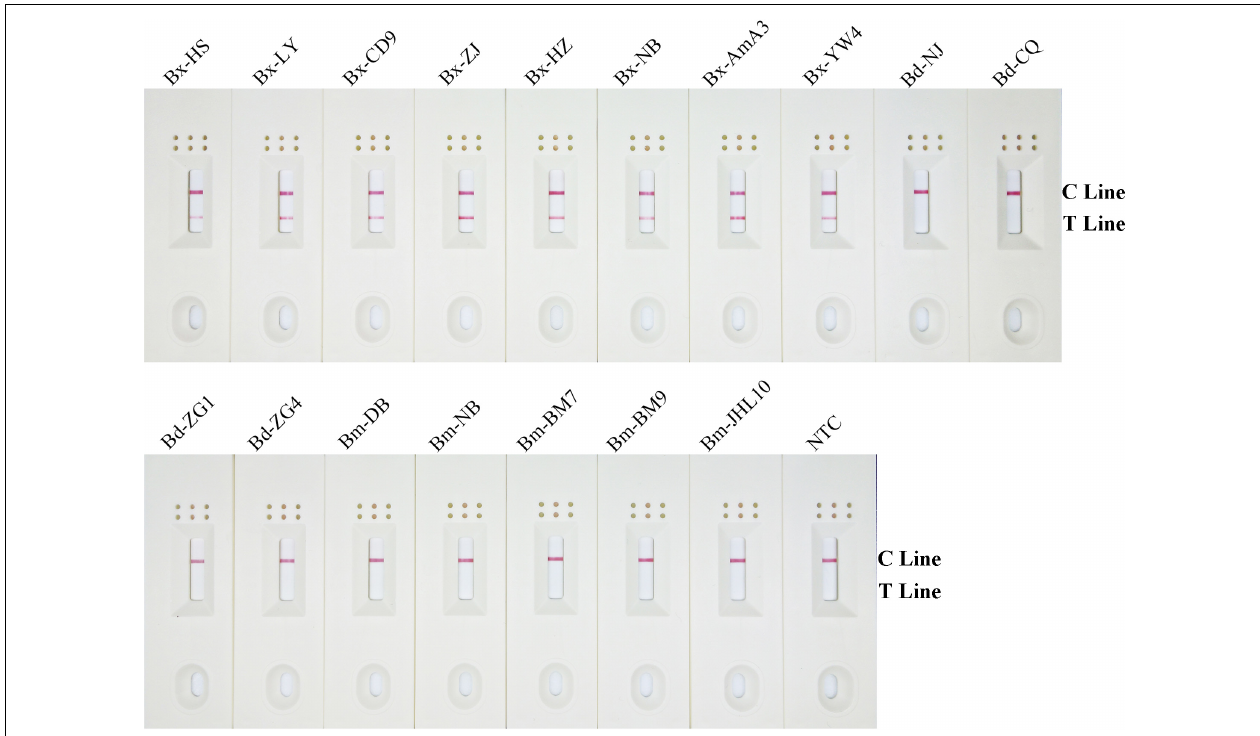
FIGURE 5 | Detection specificity of the modified primer–probe set in RPA–LFD assay. Specificity determination of RPA-LFD using different nematode isolates gDNA templates. The isolate of nematode is marked above each dipstick. The NTC dipstick is no template control. The positions of test and control lines are shown on the right side of dipstick. Reactions are carried out at 38 ◦ C for 10 min.